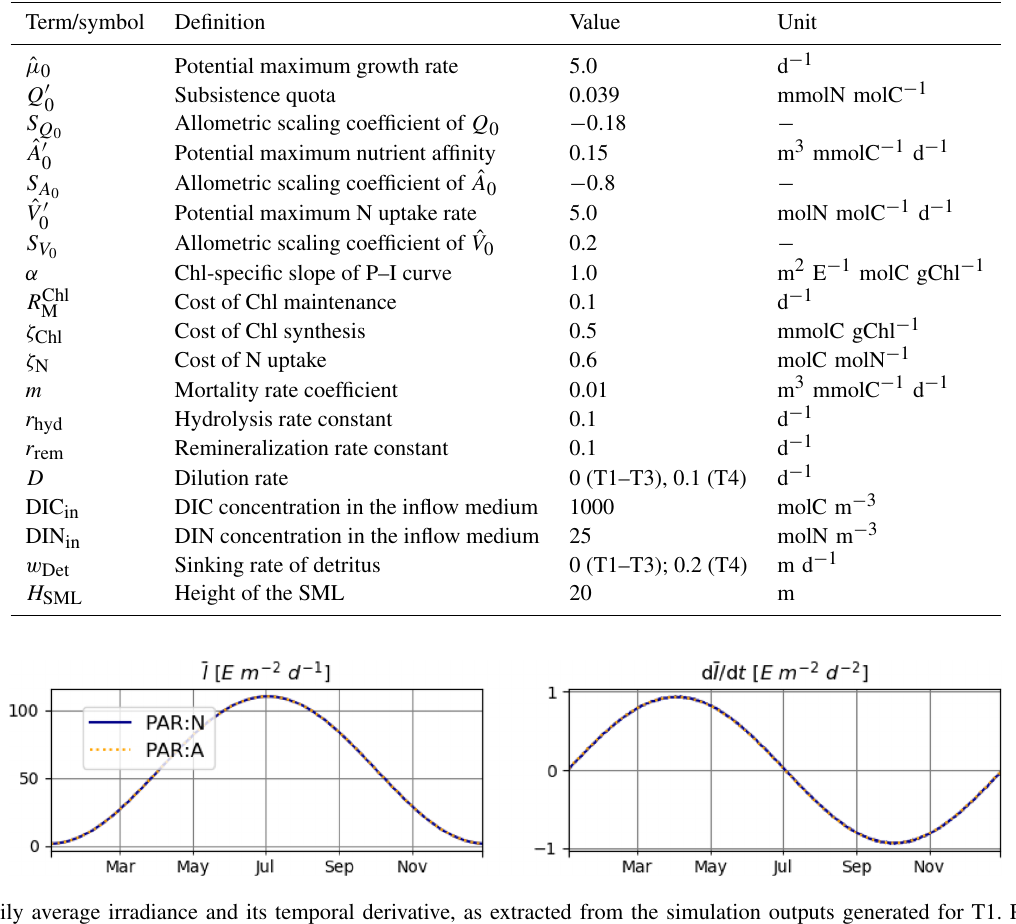
Table 1. Descriptions, values, and units of model parameters regarding phytoplankton growth. Parameters with prime ( C (cid:48) ) are for a cell with an equivalent spherical diameter (ESD) of 1µm, which is the size assumed for experiments T1 and T2. For T3, where different size classes are simulated, the respective values are obtained according to C = C (cid:48) · ESD S C , where S C is the allometric scaling coefficient for this parameter. Values for C (cid:48) and S C are as in Smith et al. (2016), and other parameters as in Kerimoglu et al. (2021).